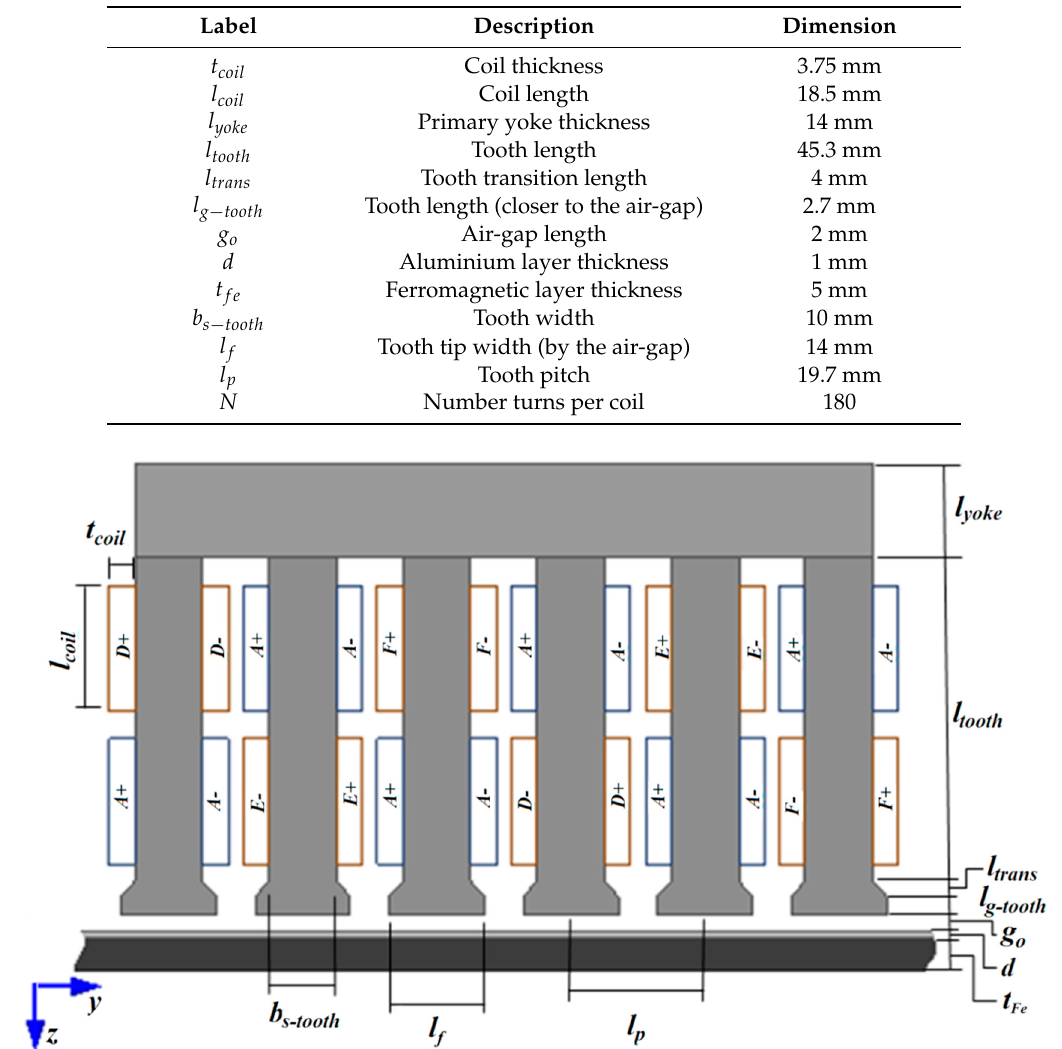
Table 1. Dimensions of the induction planar actuator [11]. © 2015 IEEE. Reprinted, with permission, from IEEE Transactions on Magnetics.